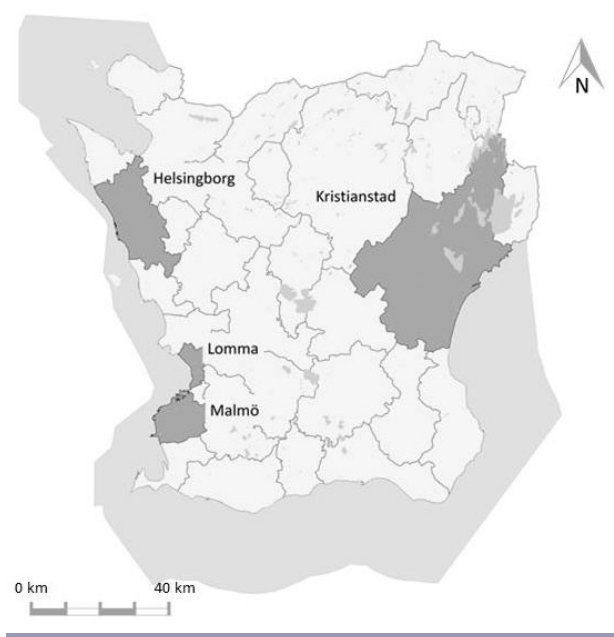
Fig. 1 . Case study areas in Scania County, Southern